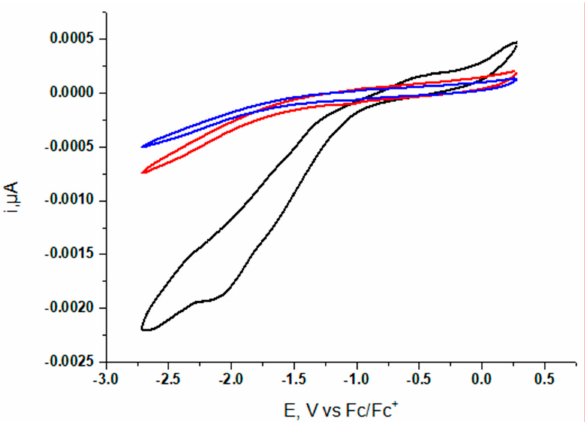
Figure 6. Rinse tests for 1 in the presence of 12 mM of TFA: ( black ) cyclic voltammogram in the presence of catalyst (10 − 3 M); ( red ) cyclic voltammogram in the absence of catalyst vs. Fc/Fc + after linear sweep voltammetry; ( blue ) cyclic voltammogram in the absence of catalyst vs. Fc/Fc + after 3 min potential application (glassy carbon working